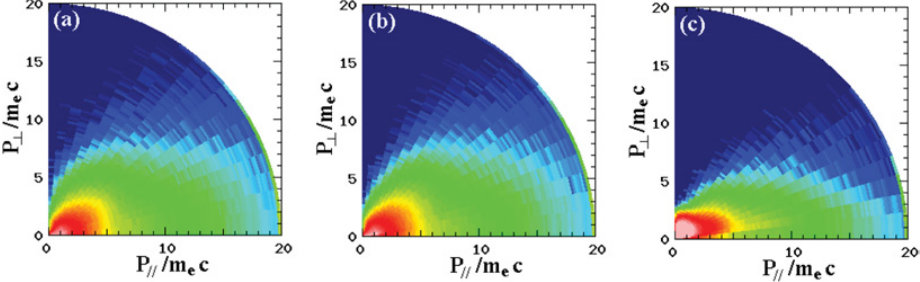
Figure 3. Time integrated angular distributions of forward fast electrons for (a) T back = 1, (b) 10 and (c)